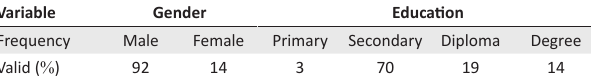
TABLE 2 : Gender and education of respondents.